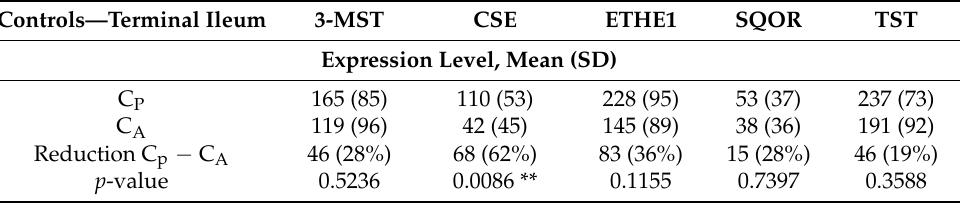
Table 2. Expression as mean with standard deviation (SD), absolute reduction and percentage as well as p -value of the terminal ileum of the healthy control group (C) separated by age group. Pediatric (P); adult (A). cystathionine- γ -lyase (CSE), 3-mercapto-sulfurtransferase (3-MST), ethyl- malonic encephalopathy 1 protein (ETHE1), sulfide:quinone oxidoreductase (SQOR) and thiosulfate sulfurtransferase (TST). ** = p -value <